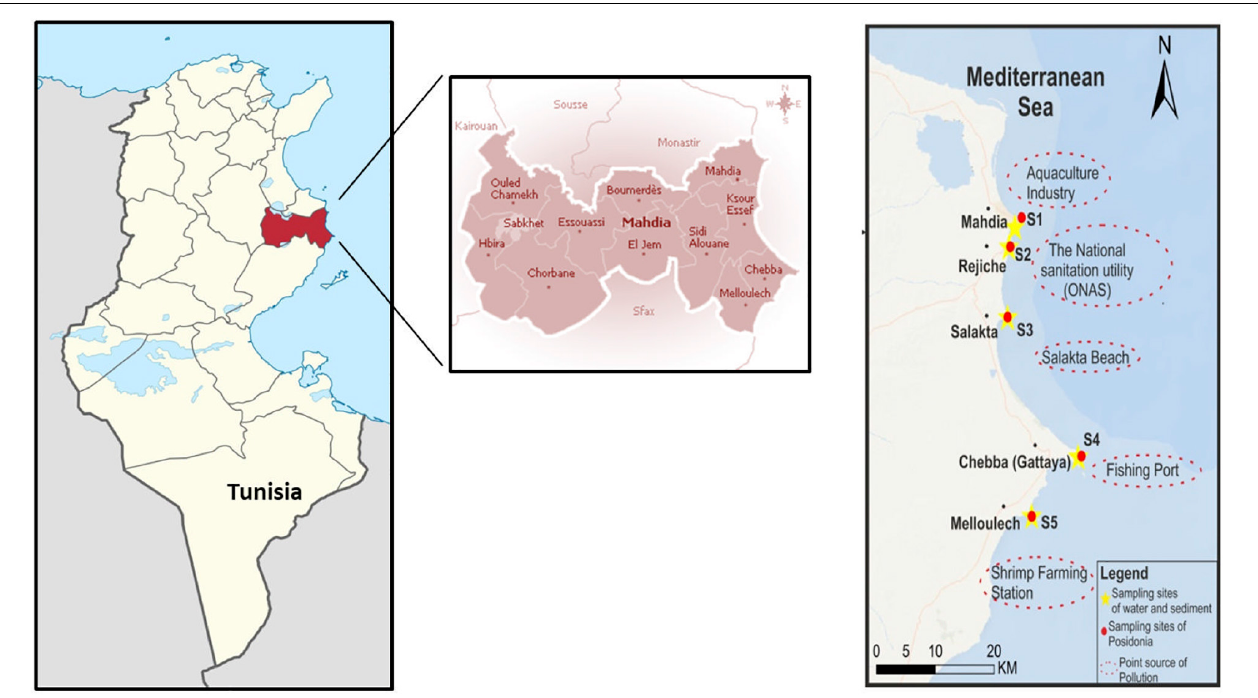
FIGURE 1 | Map illustrating the geographical location of the Mahdia governorate (Tunisia) and of the sampling sites S1–S5 (S1, Mahdia; S2, Rejiche; S3, Salakta; S4, Chebba; S5, Melloulech) considered in the present